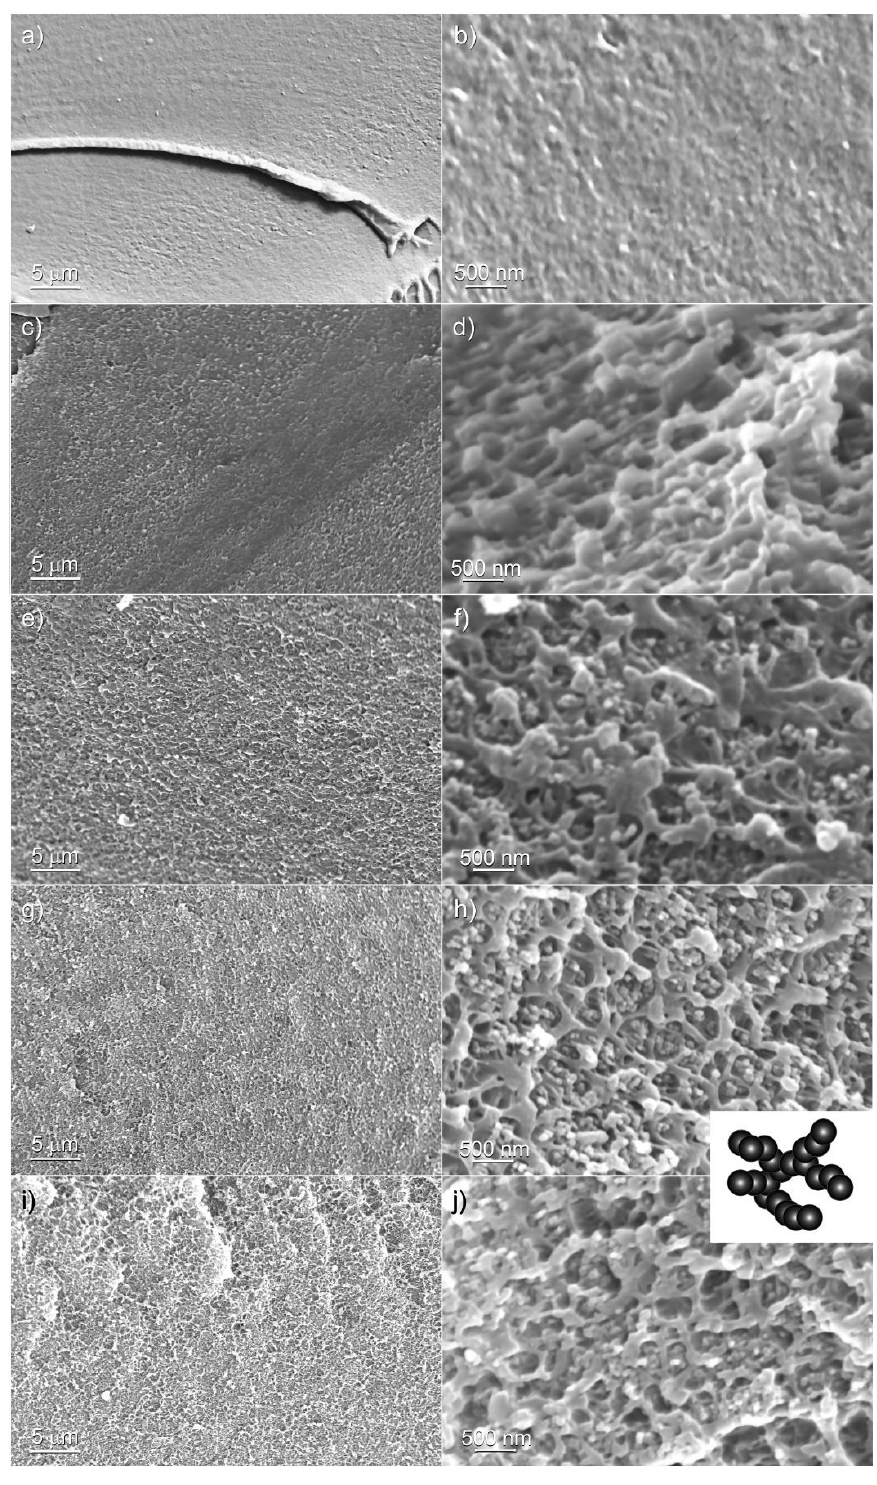
Figure 4. SEM images of PC and CB-filled PC cryo-fractured surfaces at the different CB content: ( a , b ) 0%, ( c , d ) 10 wt.%, ( e , f ) 13 wt.%, ( g , h ) 14 wt.% and ( i , j ) 15 wt.%, respectively. In the inset of ( h , j ), the CB agglomeration in the polymer matrix is illustrated.